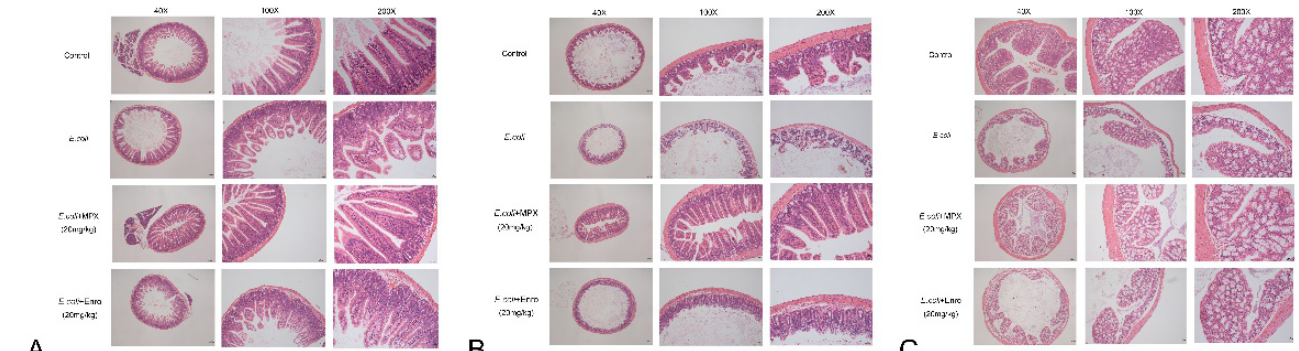
Fig. 4 . H&E staining of intestines after E. coli infection in mice. A: H&E staining of duodenum after E. coli infection in mice; B: H&E staining of ileum after E. coli infection in mice; C: H&E staining of the colon after E. coli infection in mice MPX relieves pathological damage of organs in mice.